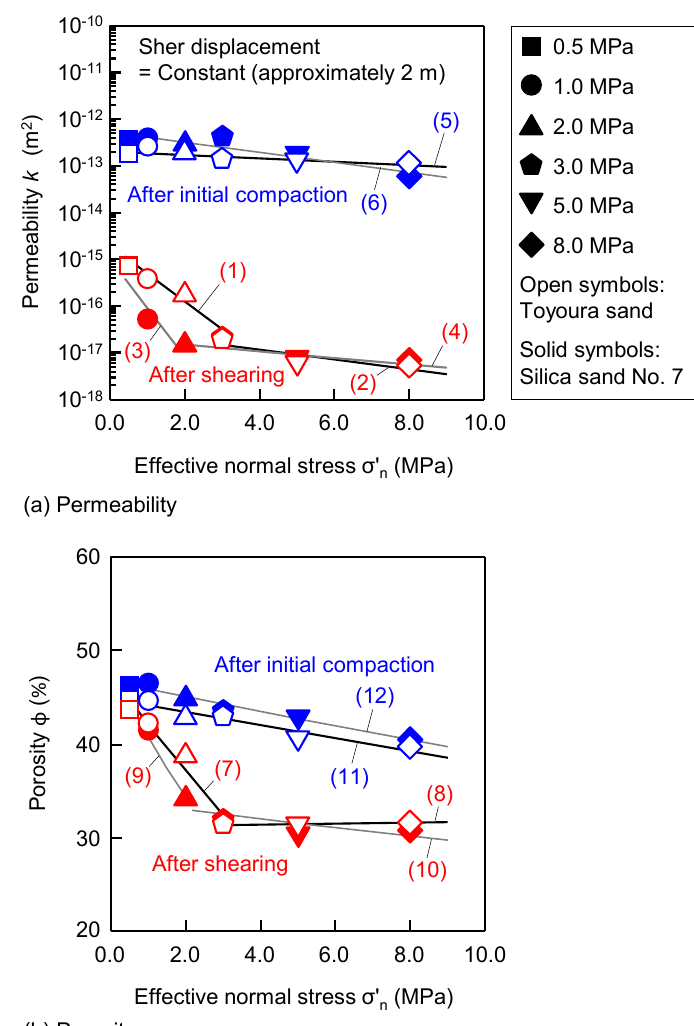
Figure 5. Variation in ( a ) permeability and ( b ) porosity with respect to effective normal stress for Toyoura sand (open symbols) and silica sand No. 7 (solid symbols). Numbers in parentheses indicate the correlations listed in Table